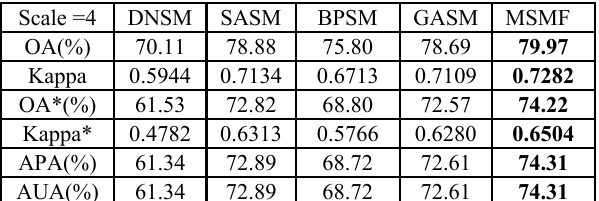
Figure 4. The sub-pixel mapping results in the experiment 1